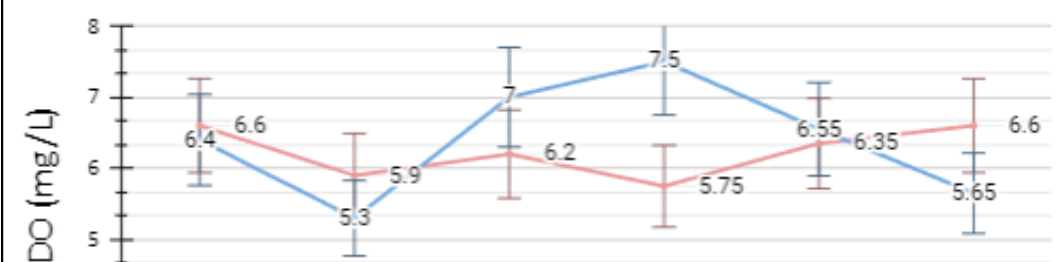
Figure 9. Water Quality — pH Level Measurements from March – May 2022.